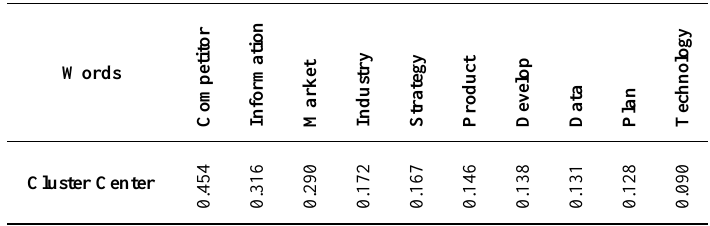
Table 6. Words and final centers of fifth cluster.